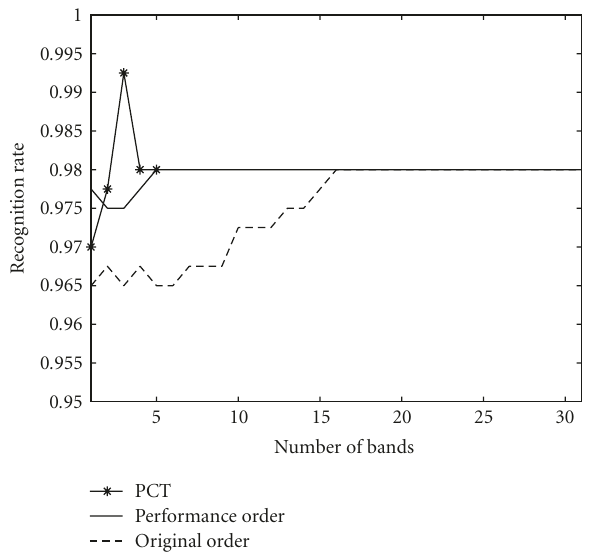
Figure 6: Recognition rate of multiband eigenface methods.